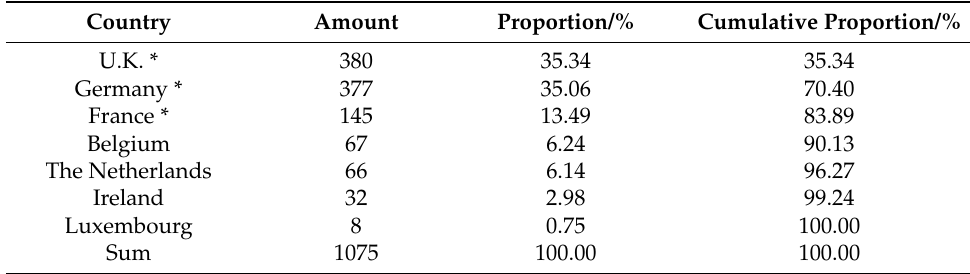
Table 1. Distribution of industrial heritage sites in Western Europe in ERIH.